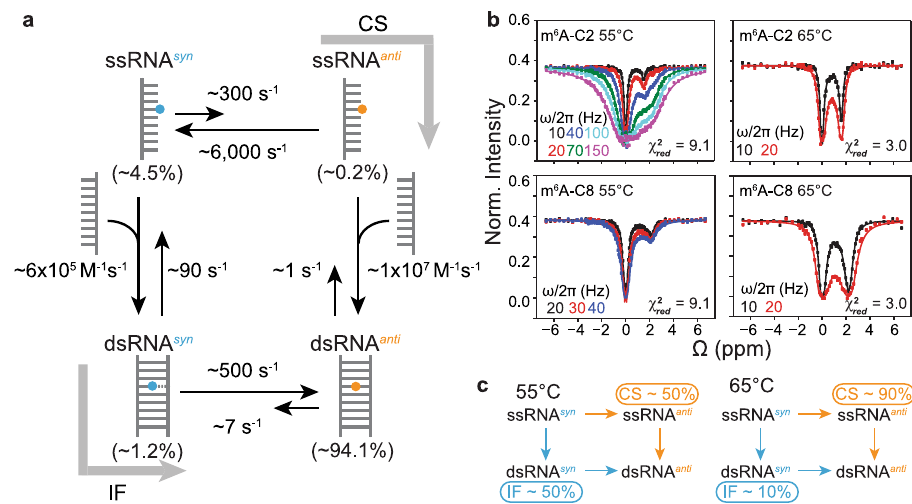
Fig. 5 Testing a four-state CS + IF kinetic model. a Schematic of the CS + IF model with populations and kinetic rate constants measured at T = 55 °C for dsGGACU m 6 A . b Constrained four-state (CS + IF model) shared fi t (solid lines) of the m 6 A C2 and C8 13 C CEST pro fi les to the Bloch – McConnell equations for dsGGACU m 6 A at T = 55 and 65 °C. χ 2 values were obtained from global fi tting m 6 A-C2 and m 6 A-C8 CEST data. RF fi eld powers for CEST pro fi les are red color-coded. Data for CEST pro fi les in panel ( b ) were presented as mean value ± 1 s.d. (smaller than data points) from n = 3 independent measurements of peak intensities at zero relaxation delay (see “ Methods ” section). c Equilibrium fl ux through CS and IF pathways at T = 55 and 65